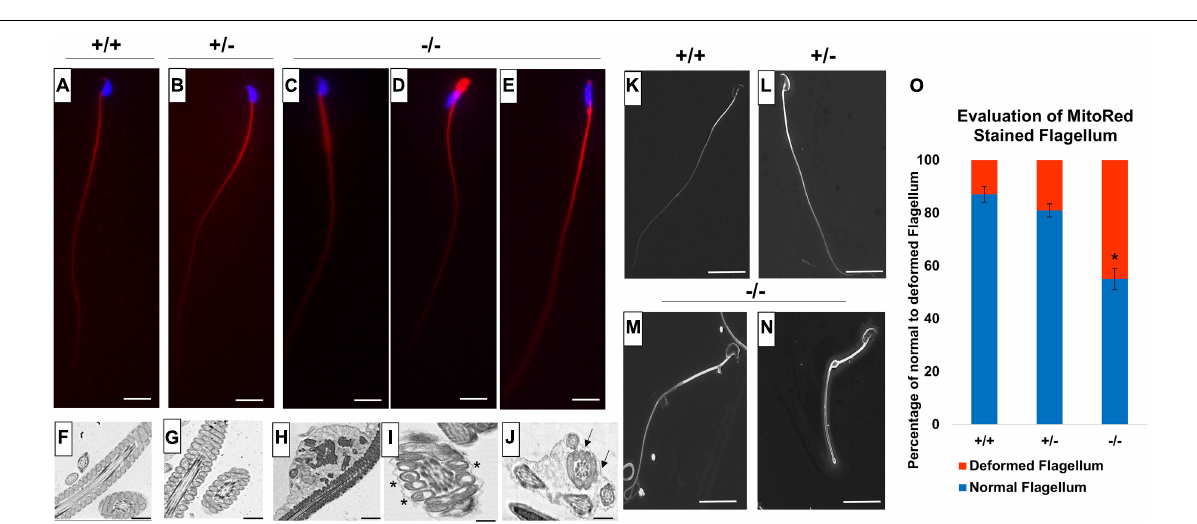
FIGURE 11 | Manchette structure stained by using α -tubulin antibody (green) on germ cell population isolated from (A) Pfn3 + / + , (B) Pfn3 + / − , and (C) Pfn3 − / − testes ( n = 3/genotype). Nuclei were stained with DAPI (blue). Scale bar = 20 µ m.